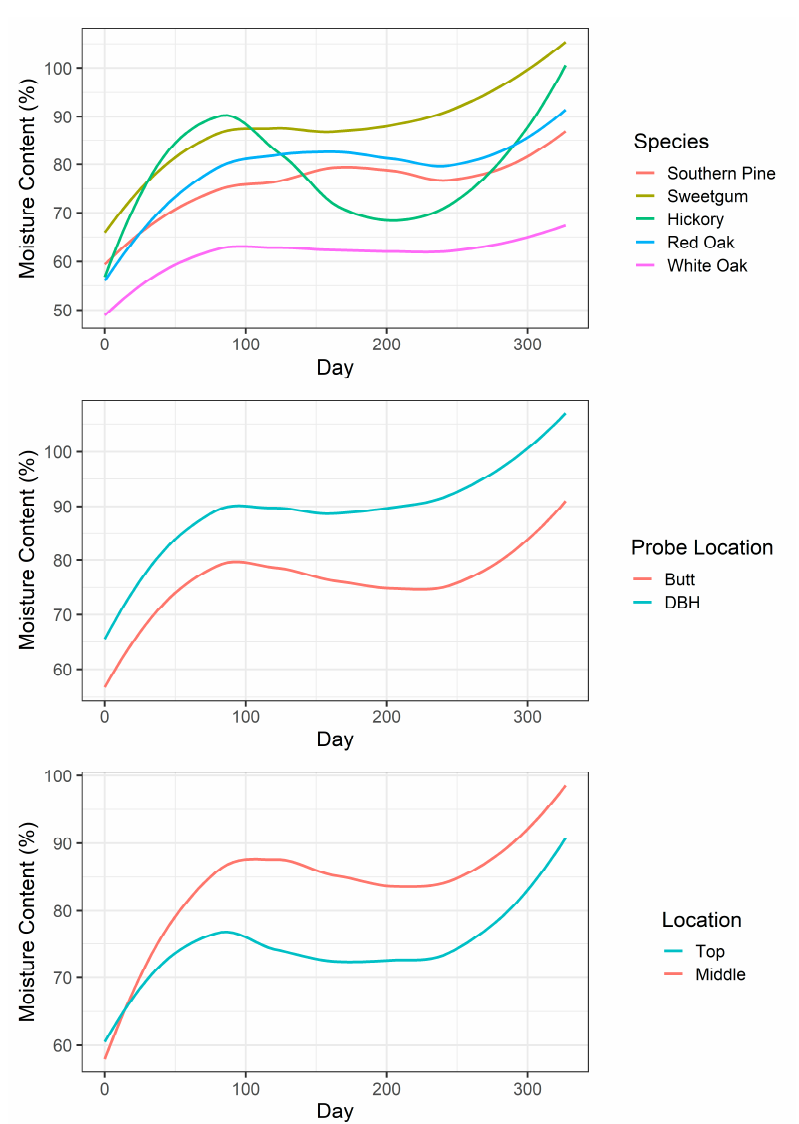
Figure 5. Moisture content vs time-domain reflectometry (TDR) reading for each species (top), probe location with the log (middle), and location of log in the pile (bottom). There were significant differences in SG pre- and post-trial by species ( p -value = 0.005); however, SG differences with location (top or mid-pile) were not significant ( p -value = 0.983) (Table 3). Most